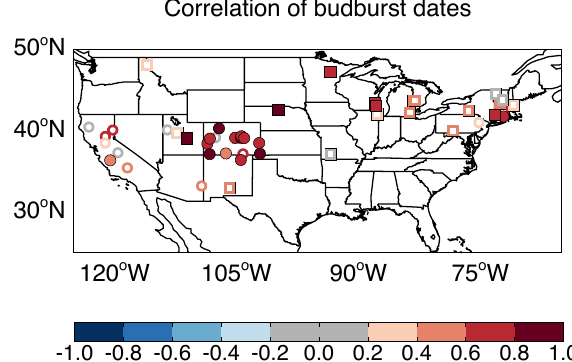
Figure 4. Correlations (circles) between the predicted budburst dates and observed first-bloom dates from the North American Lilac Network (circle) and first-leaf dates from the USA National Phenol- ogy Network (squares). Simulations are performed with the spring model S9. The correlation coefficients are calculated for individual trees with at least 6 years of observations during 1982–2012. Cor- relations with p <0.1 are denoted with filled